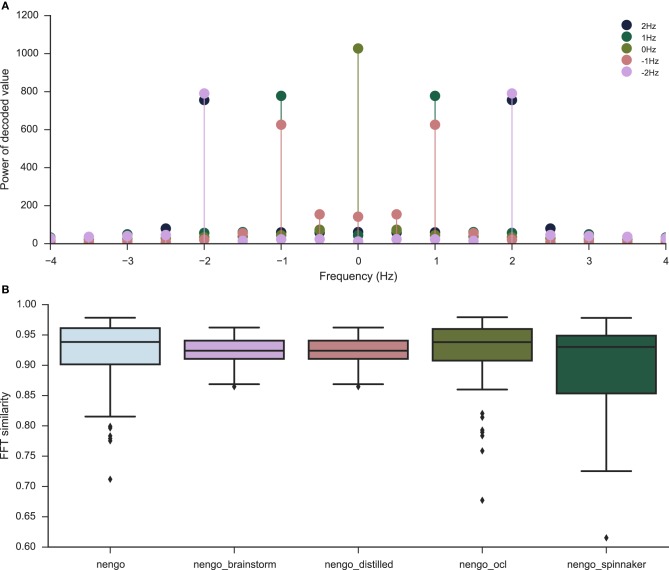
Controlled two-dimensional oscillator model. (A) One example instance of the model run on the reference backend; the power spectrum is shown for each 2 s period, colored to indicate the target frequency given by the control signal. High power is seen only at the frequency we attempt to induce, for each of the five test frequencies. (B) The aggregated accuracy results for 50 trials of each backend on the two-dimensional product model. The measured metric is the similarity between the power spectrum (calculated using the Fast Fourier Transform or FFT) of the decoded output of one of the two oscillatory dimensions in the ensemble, and the ideal power spectrum, computed on a pure sine wave oscillating at the induced frequency. Similarity is computed using a normalized dot product across all frequencies. The box shows the median and interquartile range, while the whiskers extend to the farthest data point within 1.5 times the interquartile range; outliers are shown above and below the whiskers.